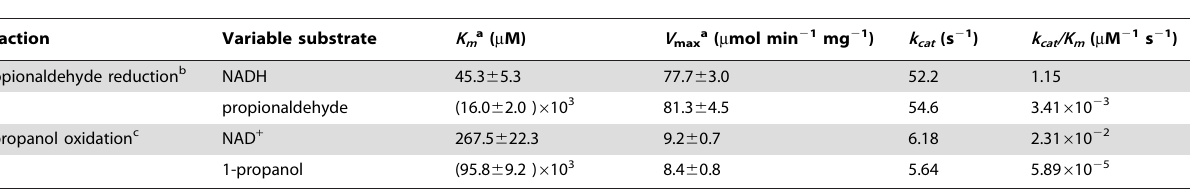
Table 3. Kinetic parameters for propionaldehyde reduction and 1-propanol oxidation by anaerobically purified PduQ-His 6 .